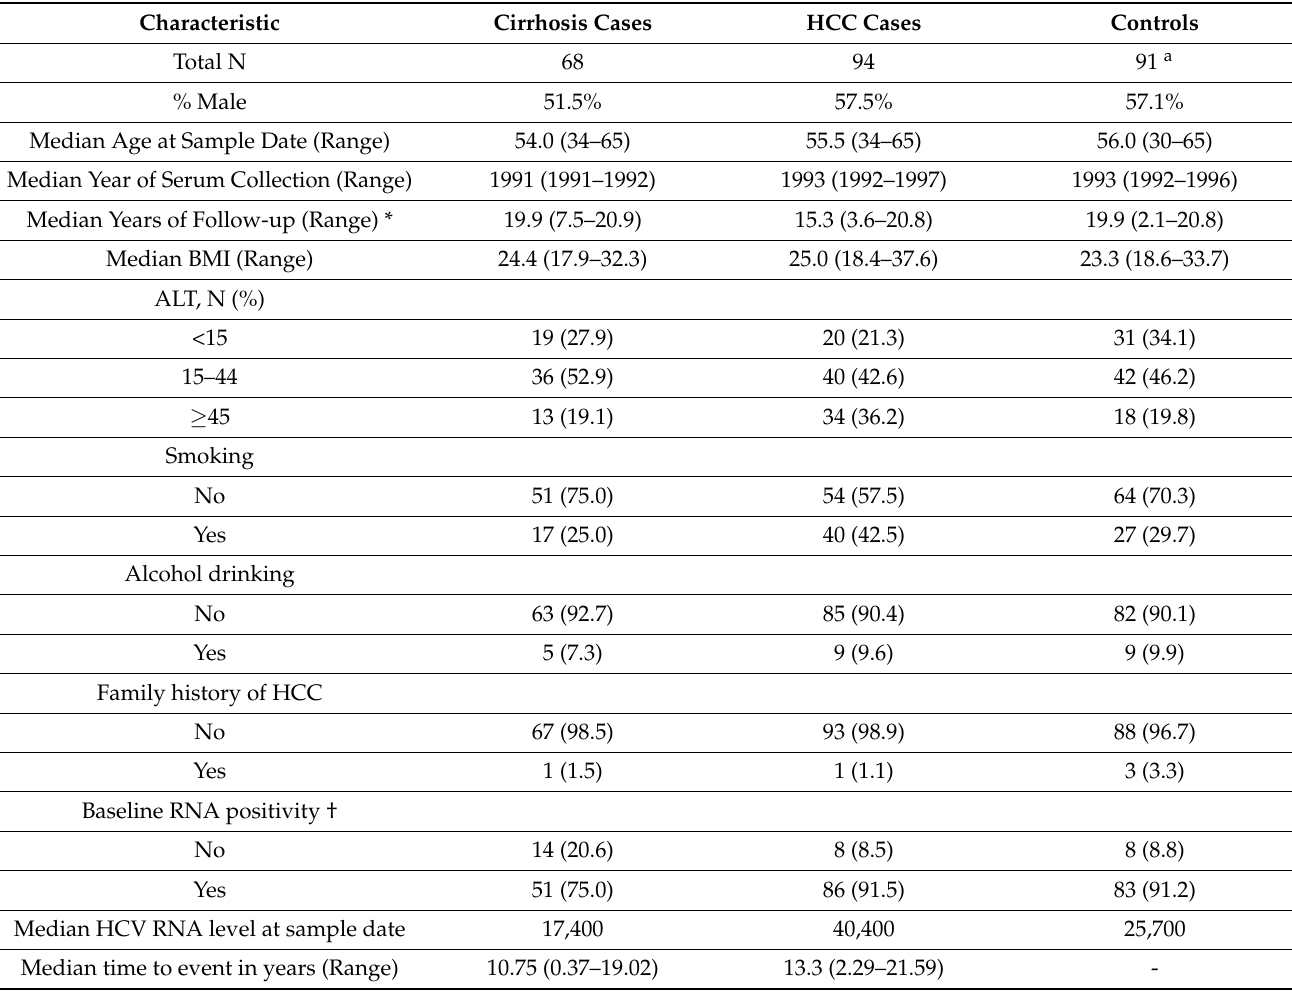
Table 1. Participant